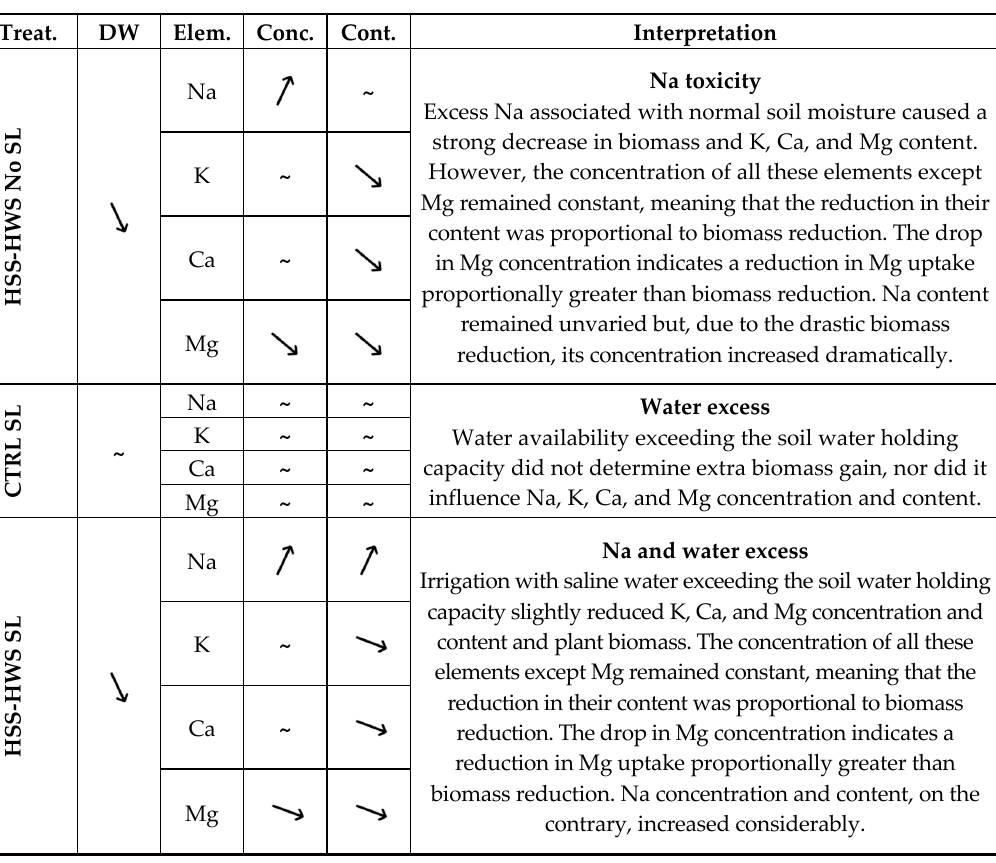
Table 4. Interpretation of the directional changes in relative dry weight (DW) and element concentration and content with respect to the reference treatment (Ctrl No SL), shown in Figure 4. Upwards and downwards arrows indicate significant changes, and ( ~ ) indicates insignificant changes. The three increasing arrow slopes indicate an increasing amplitude of the variation (from > 1 LSD to > 3 LSD).